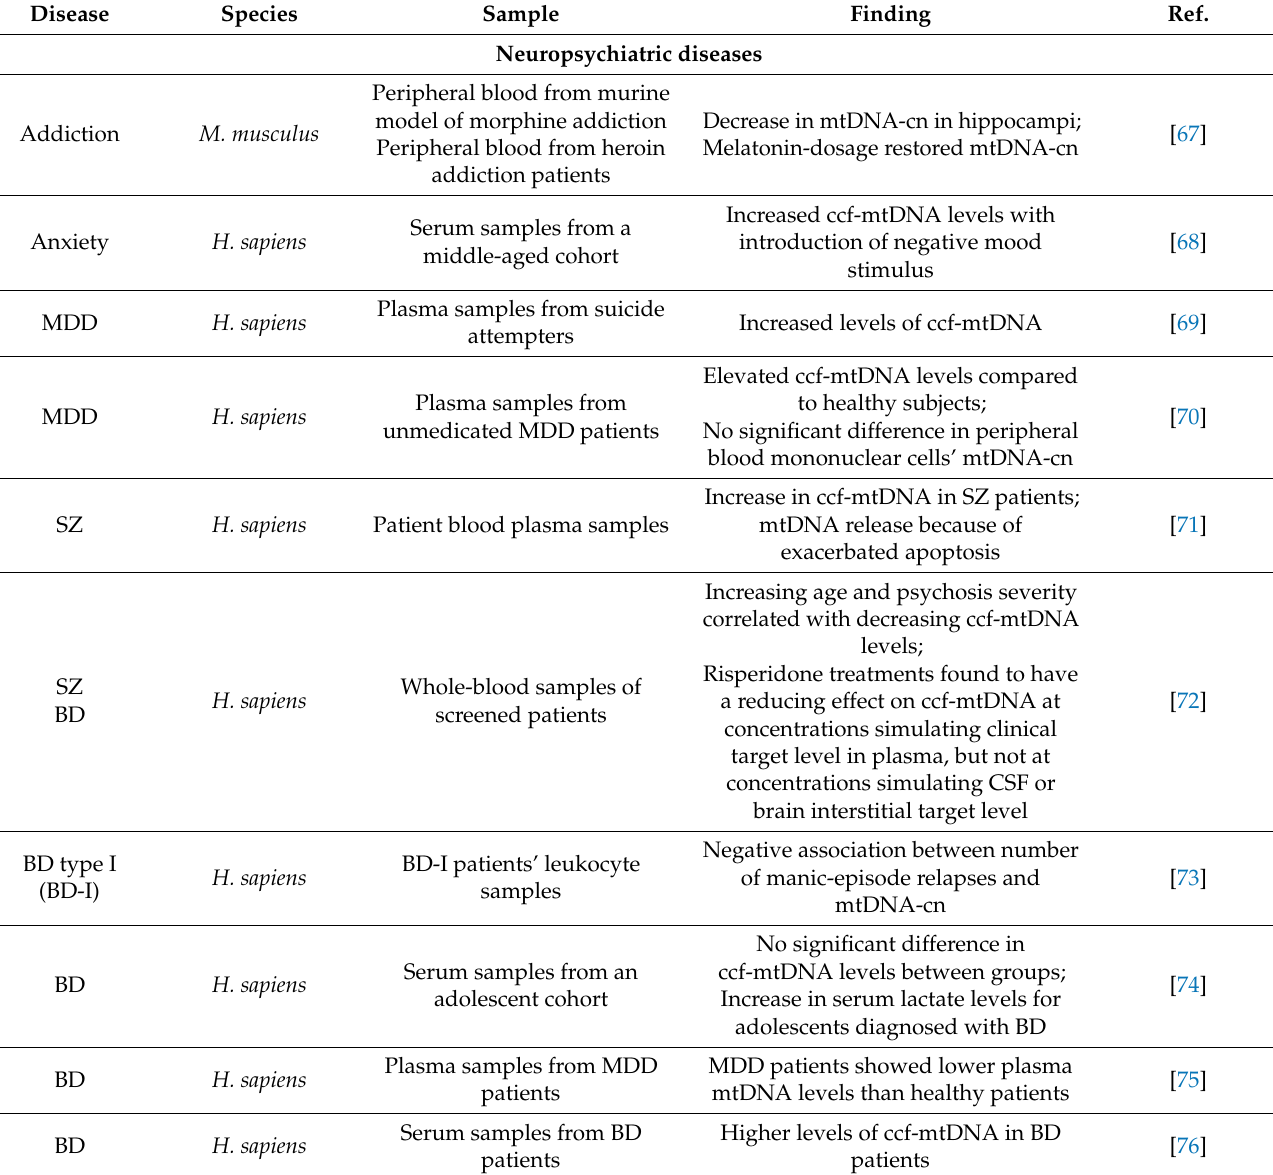
Table Abbreviations: major depressive disorder (MDD); bipolar disorder (BD); schizophrenia (SZ); multiple sclerosis (MS), Parkinson’s disease (PD), Alzheimer’s disease (AD); cerebrospinal fluid (CSF); mitochondrial DNA copy number (mtDNA-cn); circulating cell free mitochondrial DNA